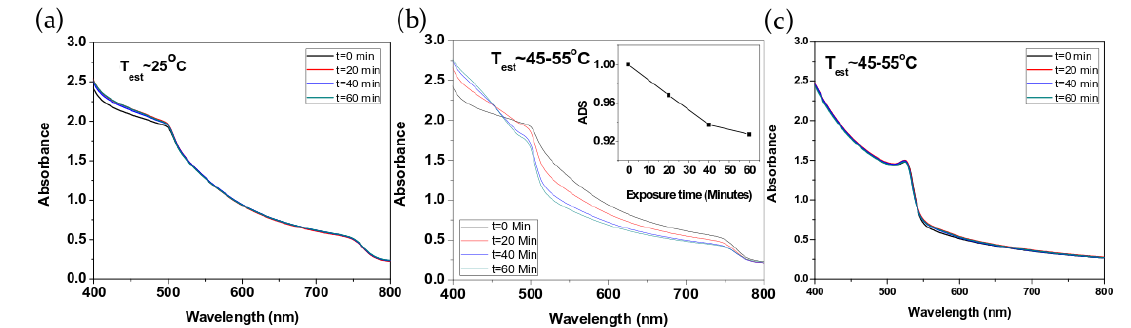
Figure 1. UV–Vis absorption spectra of encapsulated MAPbI 3 films exposed for various times at ( a ) (cid:39) 25 ◦ C and ( b ) (cid:39) 45–55 ◦ C: spectral modifications appear at high temperature, whereas ( c ) the MAPbBr (cid:39) 45–55 ◦ C. Adapted with permission from [55]. Copyright © 2015, American Chemical